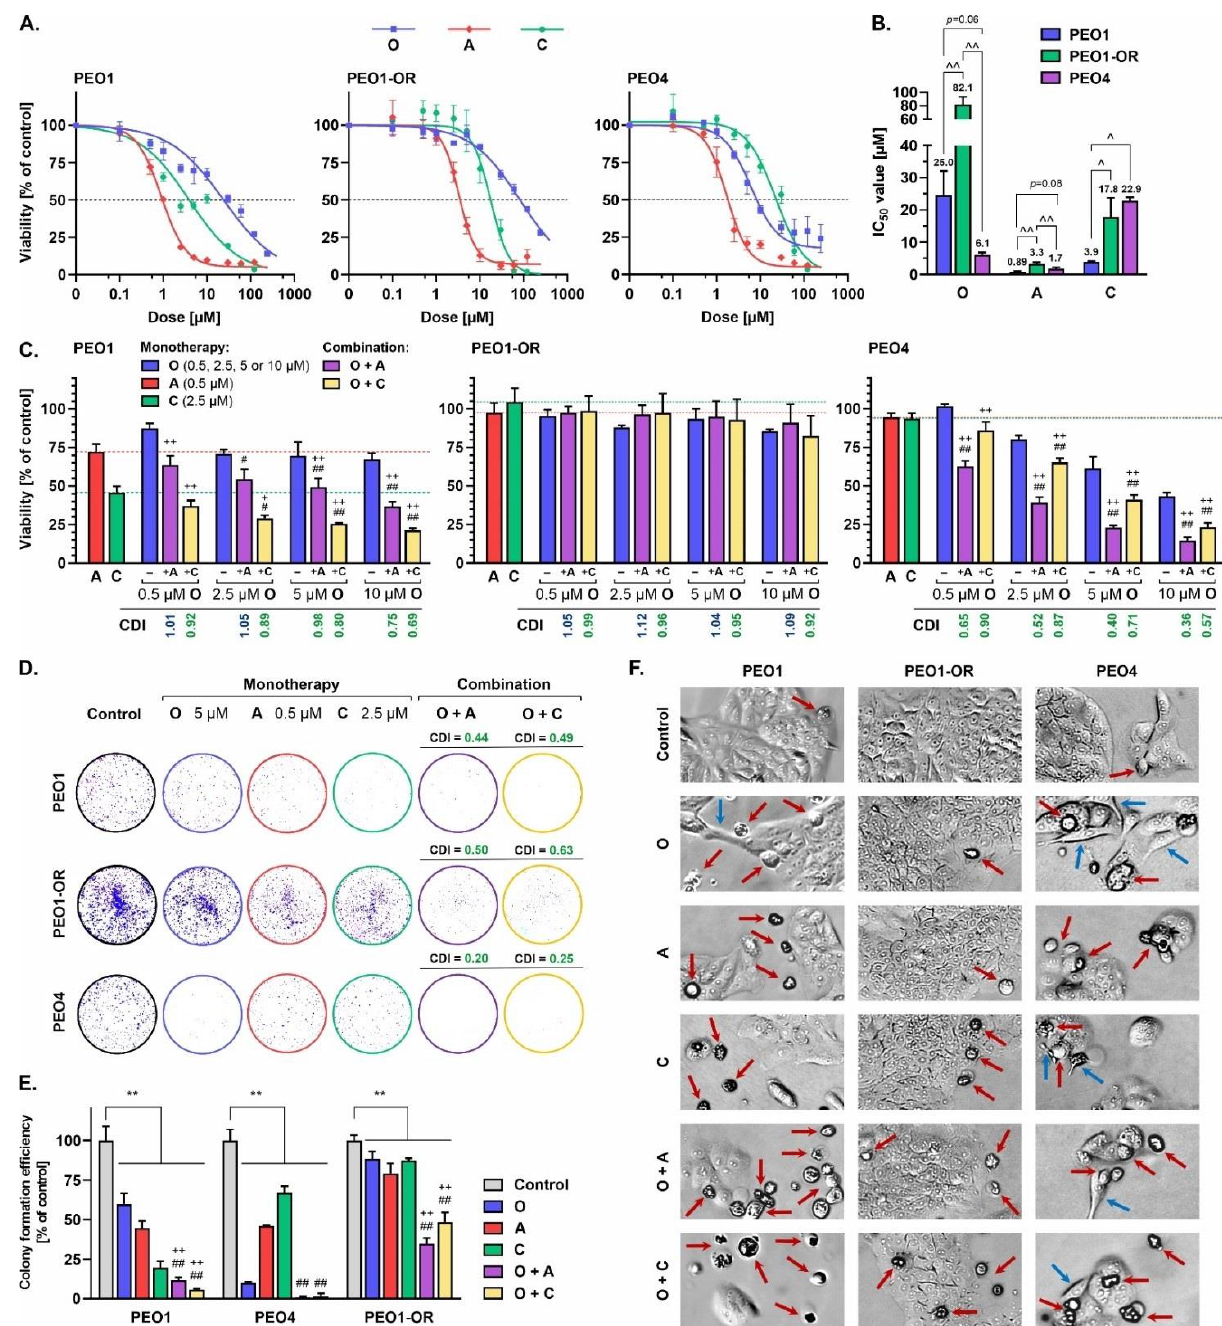
Figure 2. Olaparib combined with ATRi and CHK1i induces lower cytotoxicity in PEO1-OR cells compared to olaparib-sensitive cell lines. Cell viability in response to treatment for 5 days with olaparib (O, 0.1 –240 μM), ATRi (A, 0.1–120 μM) , and CHK1i (C, 0.1 –120 μM) was determined using the MTT assay. ( A ) A four-parameter logistic regression model was fitted to dose – response data to estimate ( B ) absolute IC 50 values. Data are expressed as mean ± SD ( n ≥ 3). ( C ) Synergistic cytotoxic effects of drugs determined with the MTT assay in response to 5-day treatment with olaparib (0.5, 2.5, 5, or 10 μM) combined with ATRi (0.5 μM) or CHK1i (2.5 μM). Data are expressed as mean ± SD ( n = 3 – 6). ( D ) The clonogenic assay was performed after incubation with olaparib (5 μM), ATRi (0.5 μM) , CHK1i (2.5 μM) , or their combinations for 5 days. After treatment, cells were allowed to grow and proliferate in the absence of drugs for 10 – 14 days. Representative images of colonies and ( E ) quantification of colony formation ability compared with control cells. Data are expressed as mean ± SD ( n = 4). ( F ) Morphological changes of OC cell lines in response to olaparib (5 μM), ATRi (0.5 μM) , CHK1i (2.5 μM) , or their combinations for 5 days. Images were captured at 10× magnifi- cation. Coefficient of drug interaction (CDI) values indicating whether interaction effects are